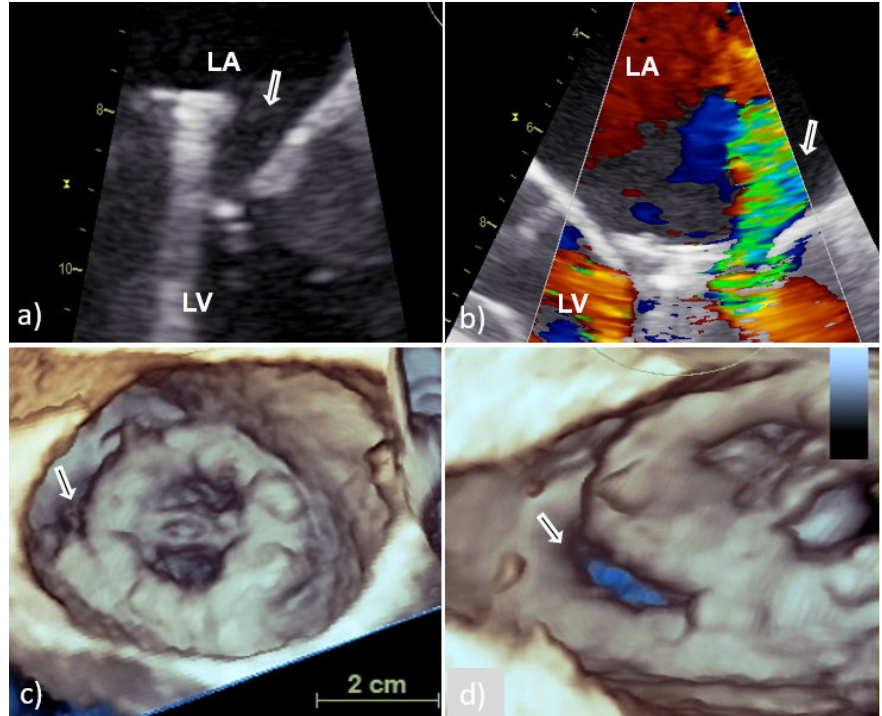
Figure 4. Transesophageal echocardiography of MVP endocarditis caused by Streptococcus bovis . Two-dimensional TEE shoved localized dehiscence of the MVP with a paravalvular leakage (white arrow) ( a , b ); surgeon’s view of MVP with suspected dehiscence (white arrow) in the lateral (8–9 o’clock) position ( c ); enlarged and rotated 3D TEE image from different angle confirms a defect (white arrow) with fairly large surface area that occupies approximately 15% of the MVP circumference and causes hemodynamically significant regurgitation ( d ). 2D TEE—two-dimensional transesophageal echocardiography; 3D TEE—three-dimensional transesophageal echocardiography; MVP—mitral valve prosthesis; LA—left atrium; and LV—left ventricle.